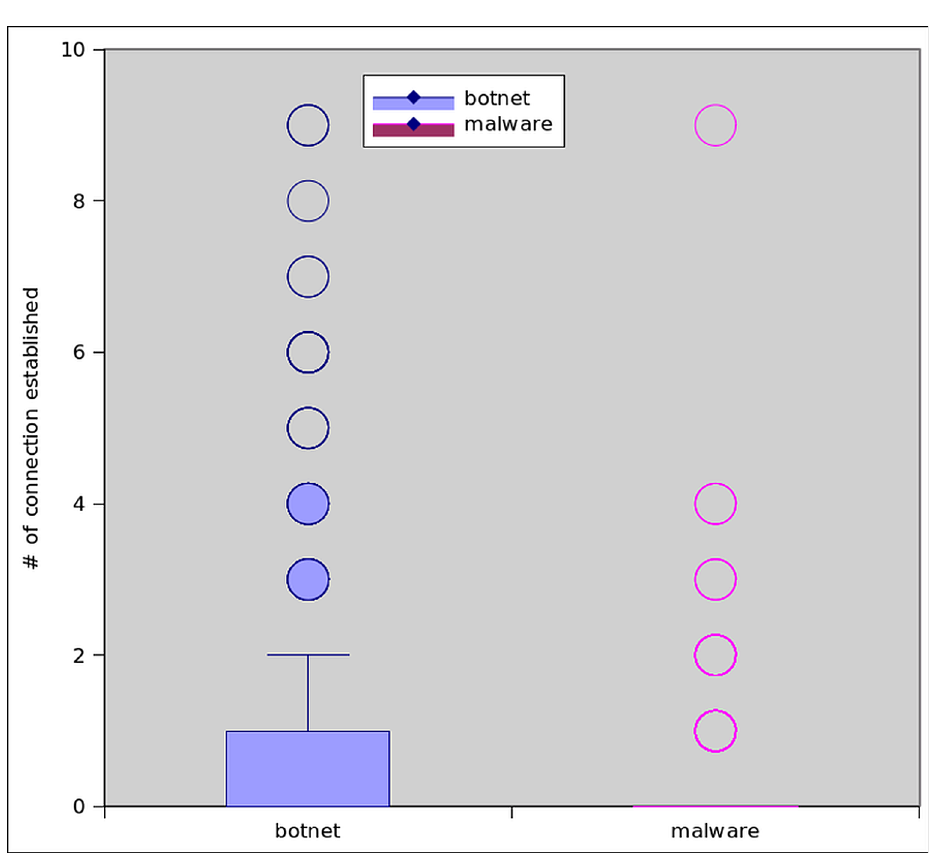
Fig 20. Total Number of Established